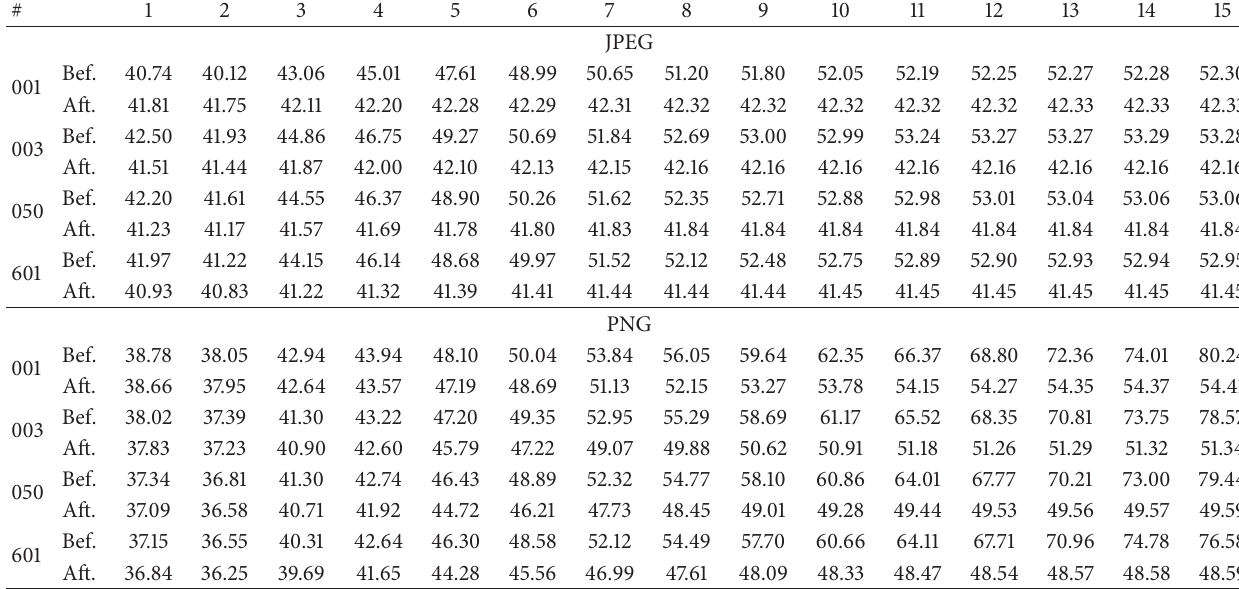
Table 14: PSNR results on median filtering